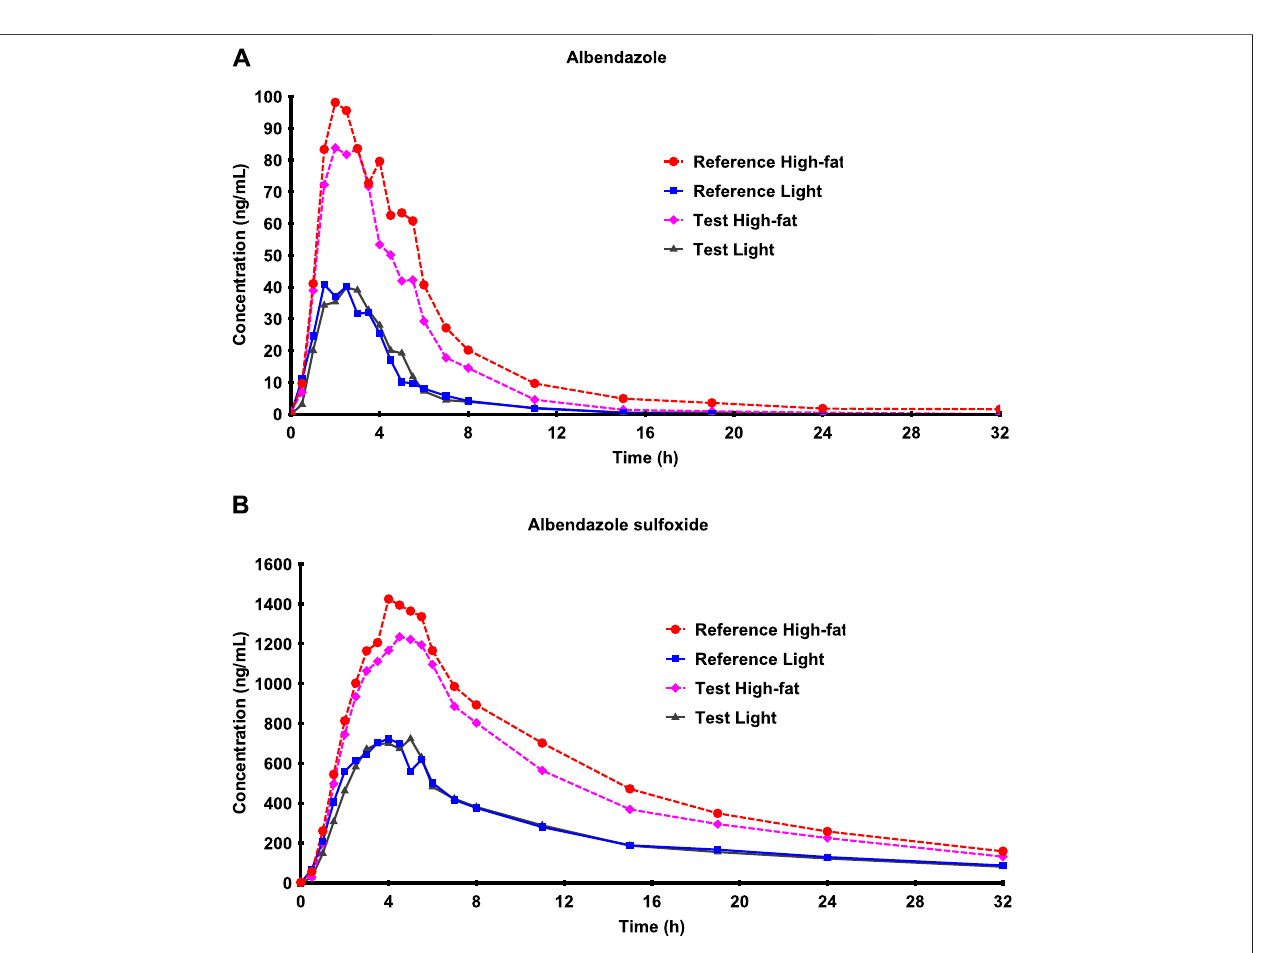
FIGURE 1 | Mean albendazole (A) and albendazole sulfoxide (B) concentration – time curves after low-fat and high-fat breakfast intake on a linear scale.